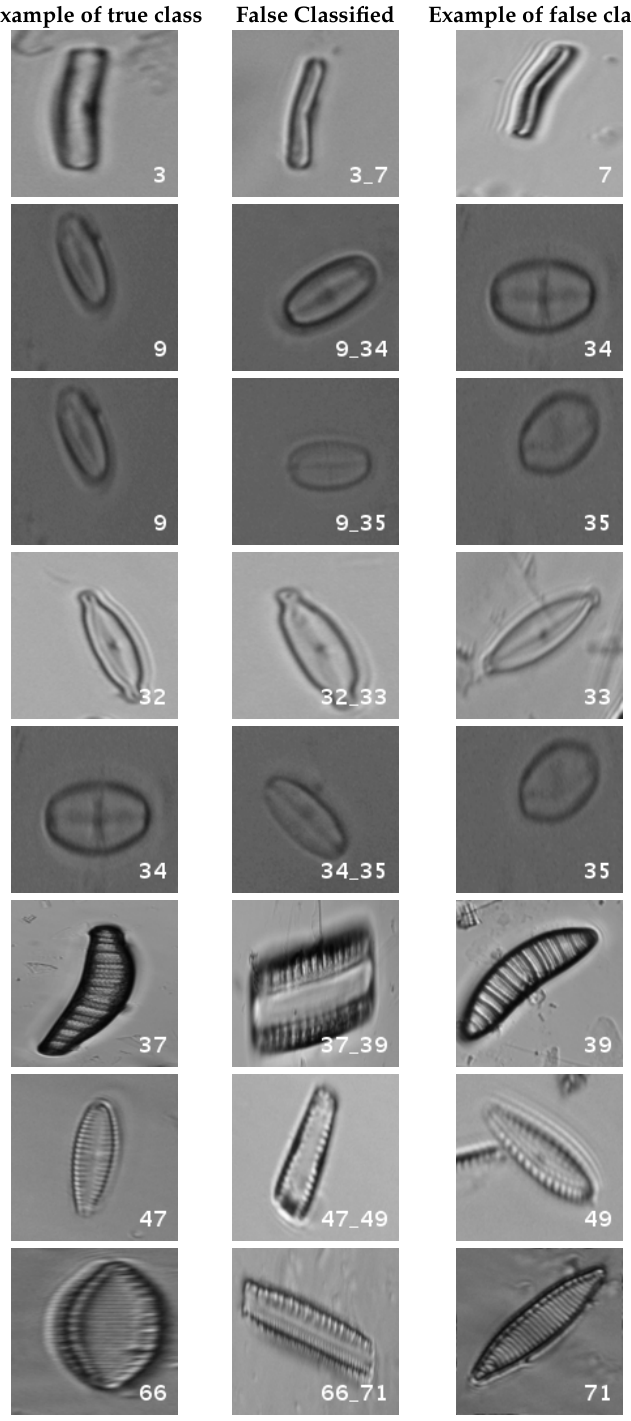
Figure 8. Original dataset main confusions. Each row shows an example of the true species, a missclassified sample between two species and a sample of the second one are